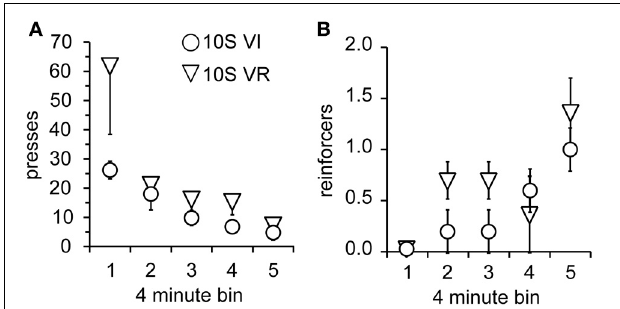
FIGURE 6 | Performance of 10S groups during first test session. (A) The number of lever presses per four-minute bin decreased similarly over the session for the 10S VI (circles) and 10S VR (triangles) groups. (B) The number of reinforcers received per four-minute bin increased similarly over the session for the two